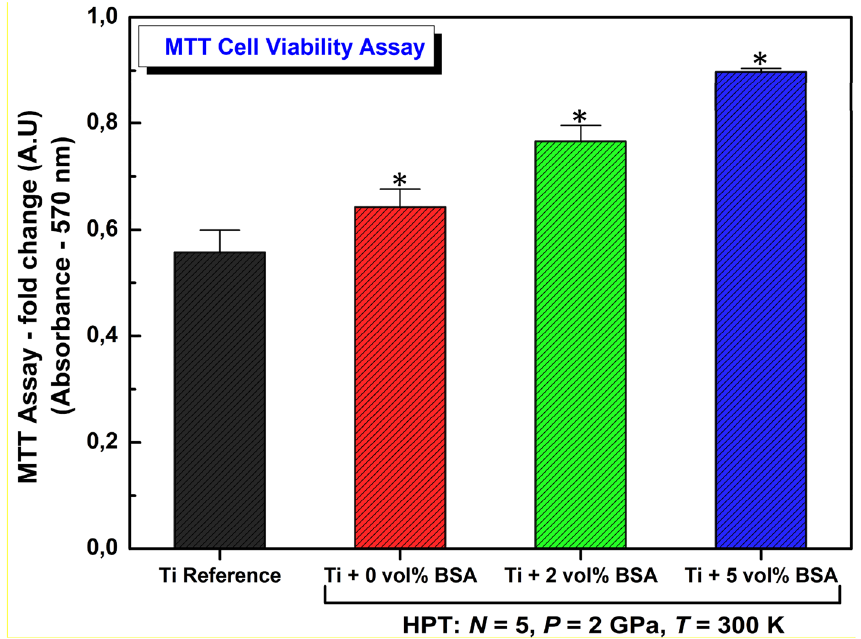
Figure 5. MTT cell viability assay examined by light absorbance at 570 nm for pure titanium and for nanocomposites containing 2 and 5 Vol% of BSA produced by 5 turns of HPT under 2 GPa in comparison with hardness of coarse-grained annealed titanium. Data are shown as mean ± standard deviation of experiments performed in quadruplicate and compared by Kruskal–Wallis ANOVA and pairwise comparisons by Mann– Whitney